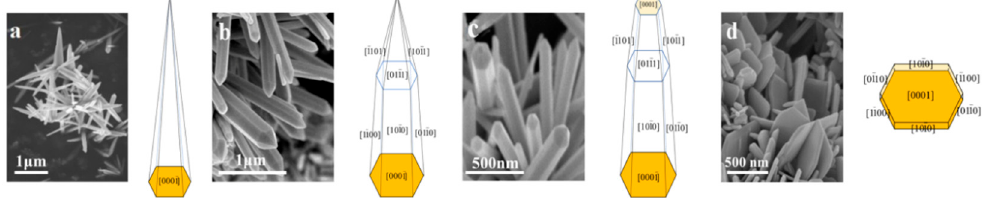
Figure 4. The schematic diagram of ZnO particles arrays with determinate crystal plane: ( a ): 0.8 g CTAB; ( b ): 1.0 g CTAB; ( c ): 1.2 g CTAB; ( d ): 1.4 g CTAB.